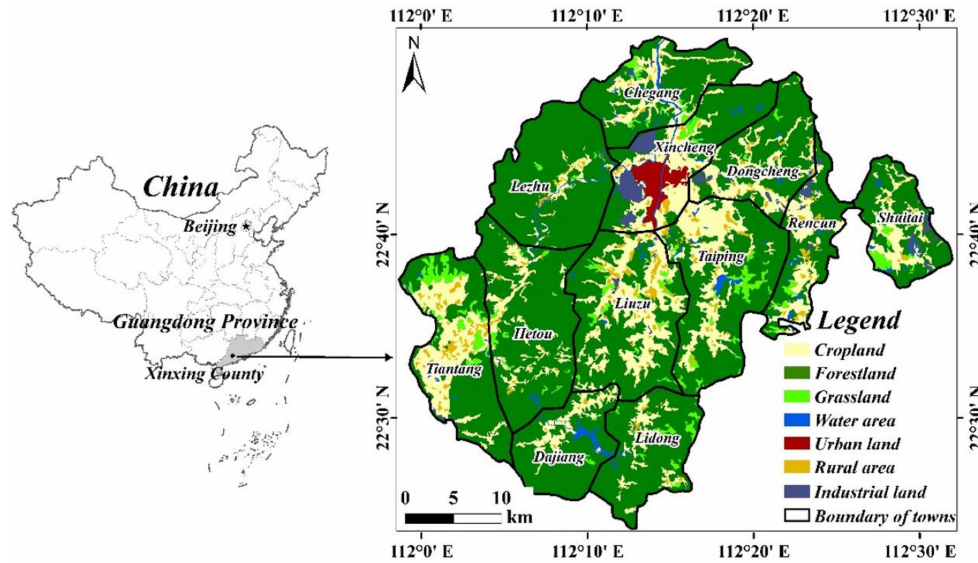
Figure 1. Location of the study